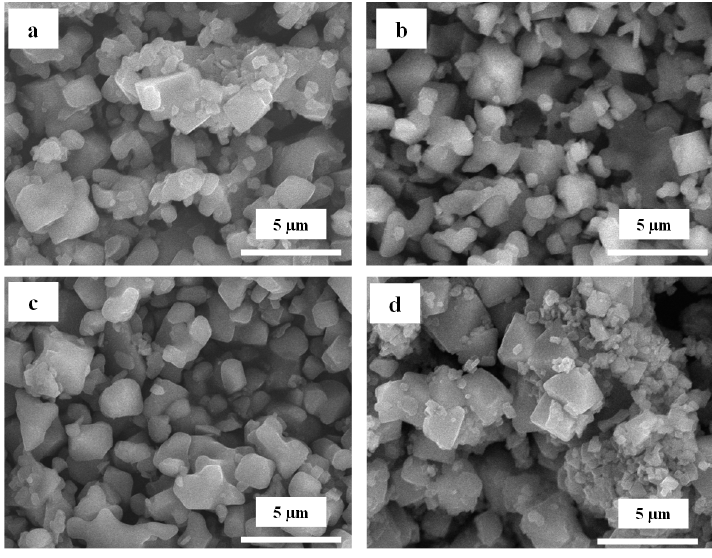
Figure 2. The 2000 × magnification SEM images of LTO with NaCl addition of: ( a ) 0 wt %, ( b ) 2 wt %, ( c ) 4 wt %, ( d ) 6 wt %.